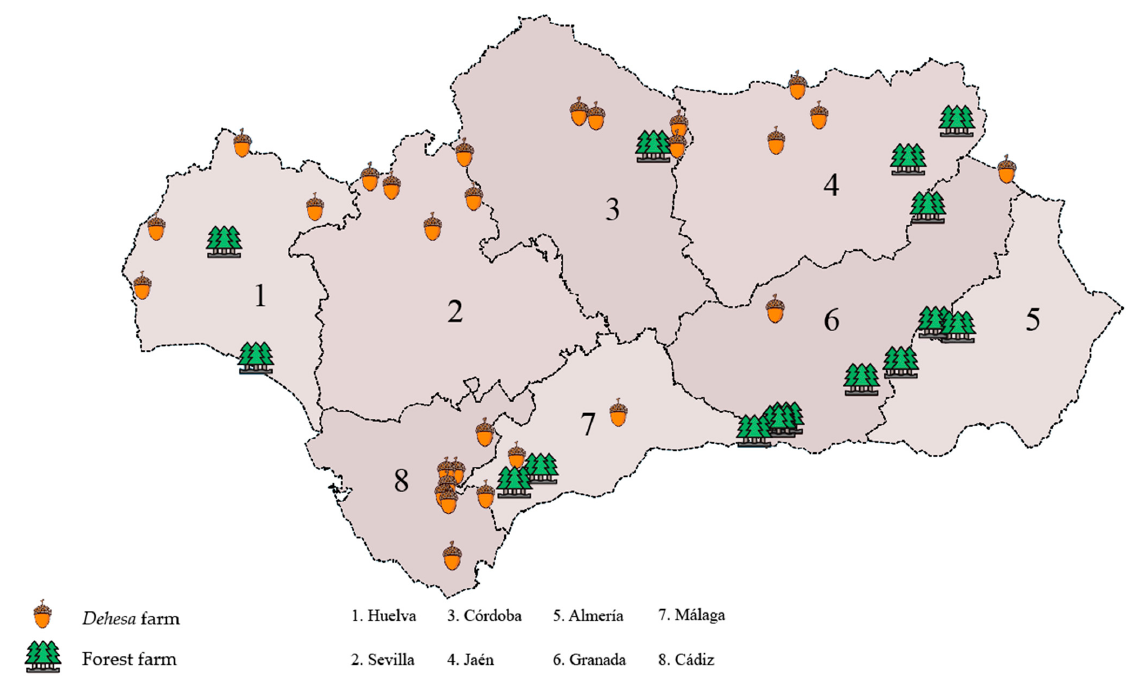
Figure 1. Location of the case-study large dehesa and forest farms in Andalusia autonomous region of Spain.